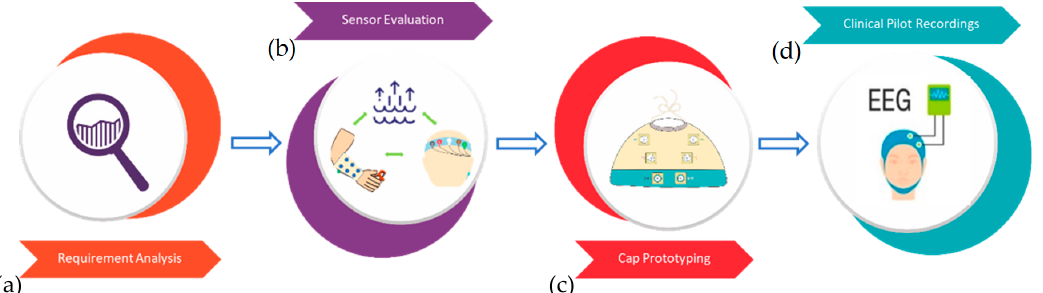
Figure 1. The study overview. ( a ) Analysis of requirements for a NICU ‐ compatible EEG cap. ( b ) Technical comparison of different materials using an armband and headband. ( c ) Construction of a fully functional cap. ( d ) Proof ‐ of ‐ concept recordings in NICU.